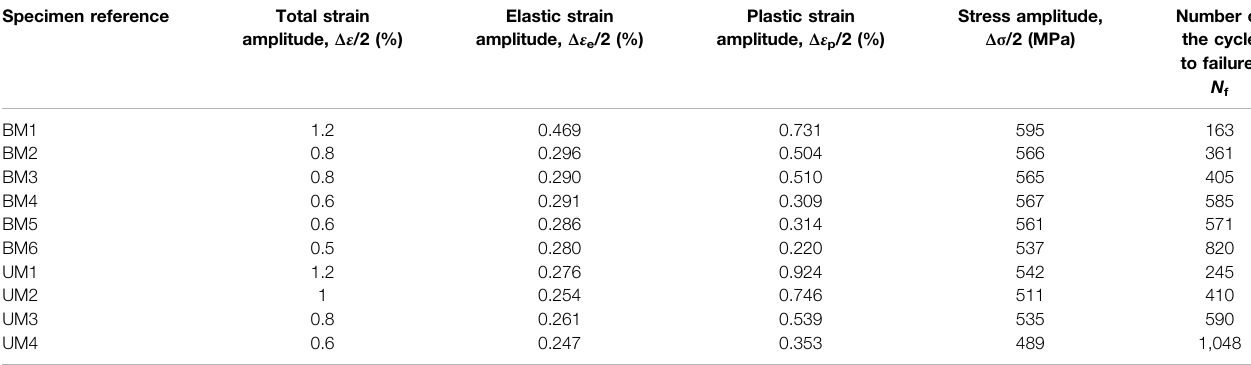
TABLE 2 | Summary of LCF test results (Song et al., 2018b). Specimen reference Total strain